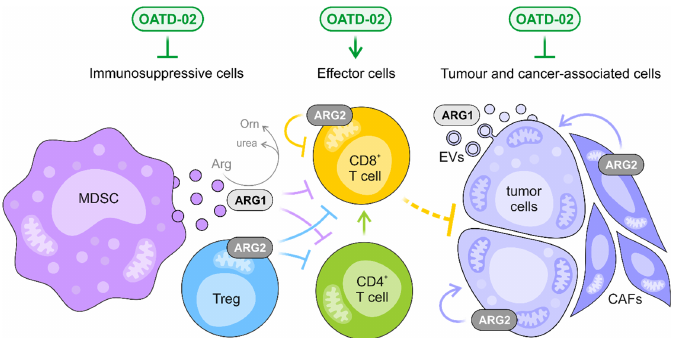
Figure 6. OATD-02 inhibits both extracellular and intracellular ARG1 and ARG2, interfering with multiple immunosuppressive mechanisms, and thus, restoring the effective antitumor immune response. OATD-02 may block the extracellular ARG1 secreted by myeloid-derived suppressor cells (MDSCs) and tumour cells, increasing the availability of L -arginine for effector T and NK cells, but most significantly, the molecule is able to target the intracellular arginases, i.e., cytoplasmic ARG1 and mitochondrial ARG2, that are crucial for the function of immunosuppressive cells, like Tregs, but also negatively regulate the fitness of cytotoxic CD8 + T cells. The unique properties of OATD-02 allow it to act on ARG1 packed into the extracellular vesicles (EVs) and counteract ARG2-dependent metabolic adaptations specific for both cancerous and cancer-associated cells, such as cancer-associated fibroblasts (CAFs).